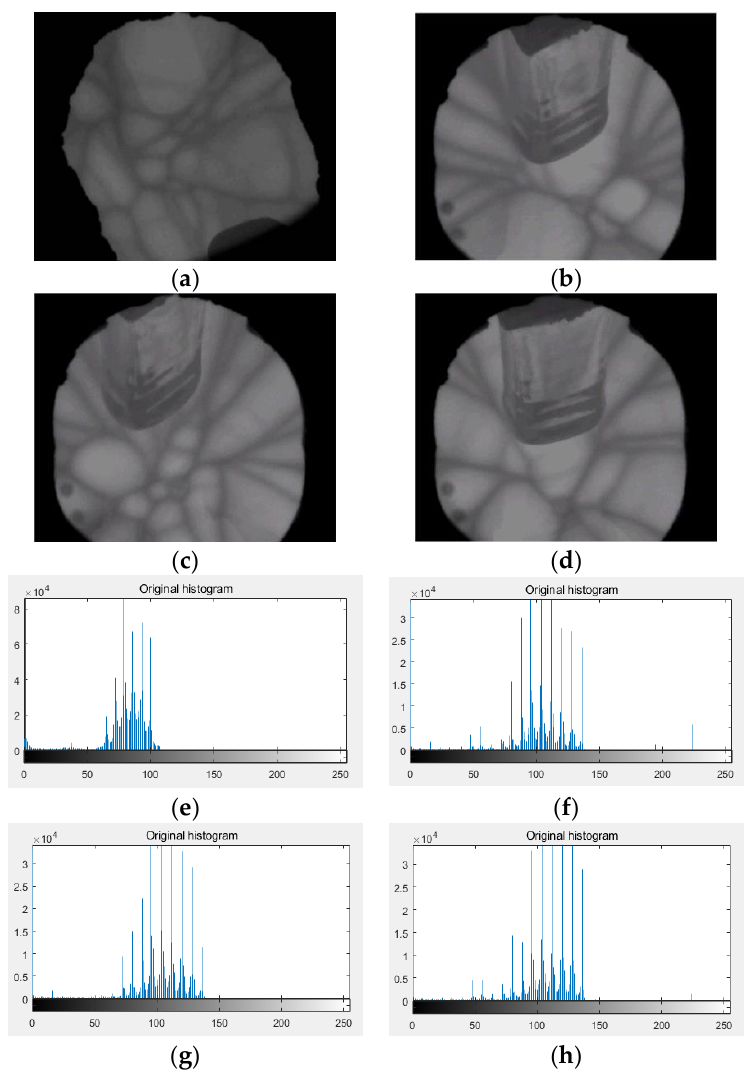
Figure 5. ( a – d ) are the original images of crystal growth images, ( e – h ) are the histograms of the original images.